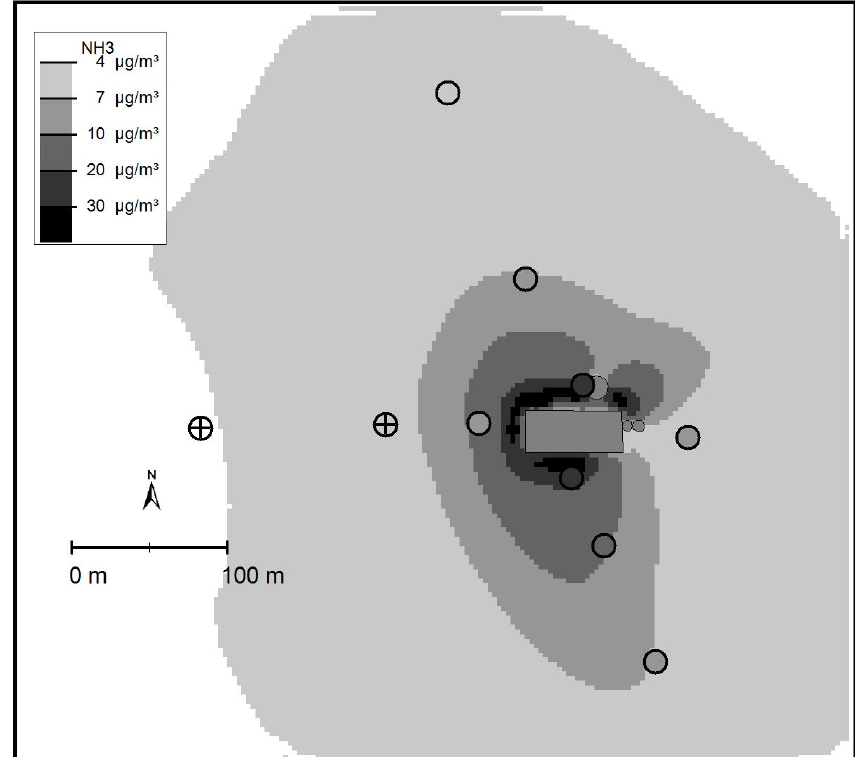
Figure 8. Simulated average ammonia concentrations with the Lagrangian particle model GRAL using an emission rate of 0.07 kg h − 1 . Observed concentrations are depicted by the circles.